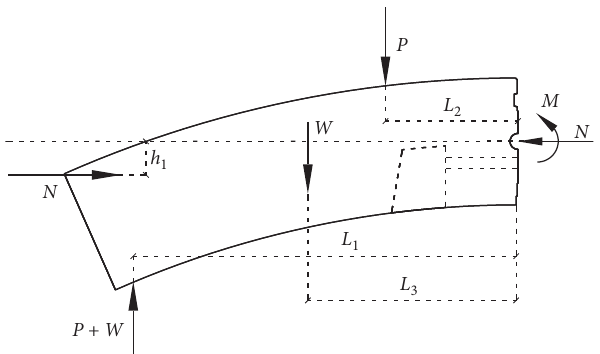
Figure 4: Half of the specimen is used for the force analysis.